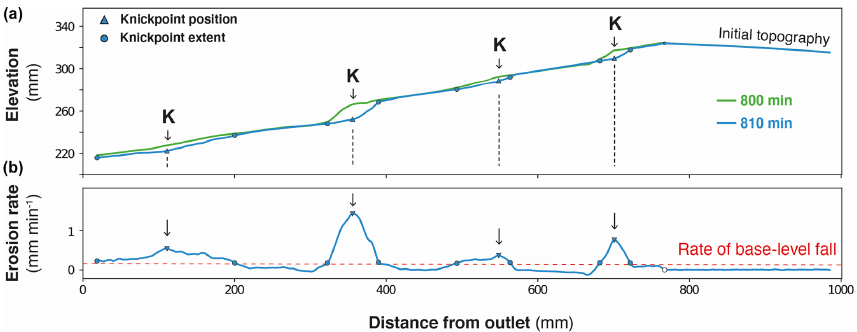
Figure 2. Graph showing two successive longitudinal profiles of experiment BL10 taken at 10min interval (a) and corresponding erosion rate profile (b) . Triangles illustrate the position of erosional peaks taken as knickpoint position (black arrows). Red dashed line shows the rate of base level